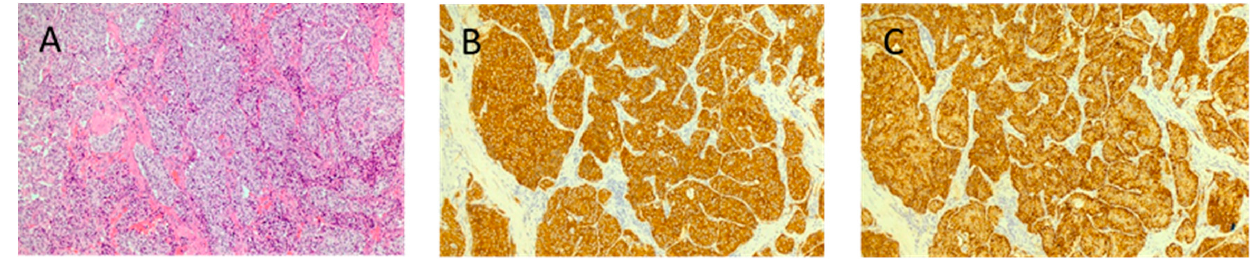
Figure 1. Representative hematoxylin and eosin stain ( A ), synaptophysin ( B ) and chromogranin ( C ) of a duodenal NEN in a 75 year old male patient. The neoplasia was characterized by low mitotic activity (MIB1-labeling index: 0.2%, mitotic index: 0), and a final diagnosis of G1 neuroendocrine tumor was reached (original magnifications: 40×).